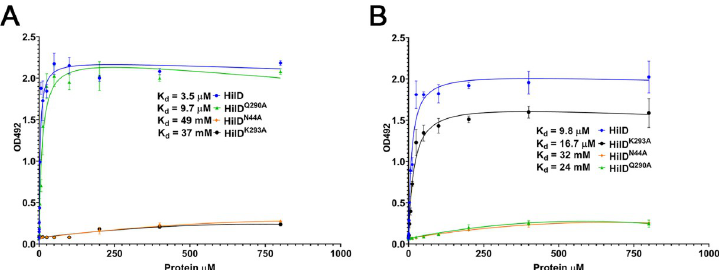
Fig 4. c2-HDA binds to HilD with higher affinity than to other repressive LCFAs. (A-B) Increasing concentrations of wild type HilD or mutant proteins were added to 96-well plates pre-adsorbed with 10 μ M c2-HDA (A) or t2-HDA (B). Binding was detected by anti-His antibody. Non-linear regression was plotted to calculate K d